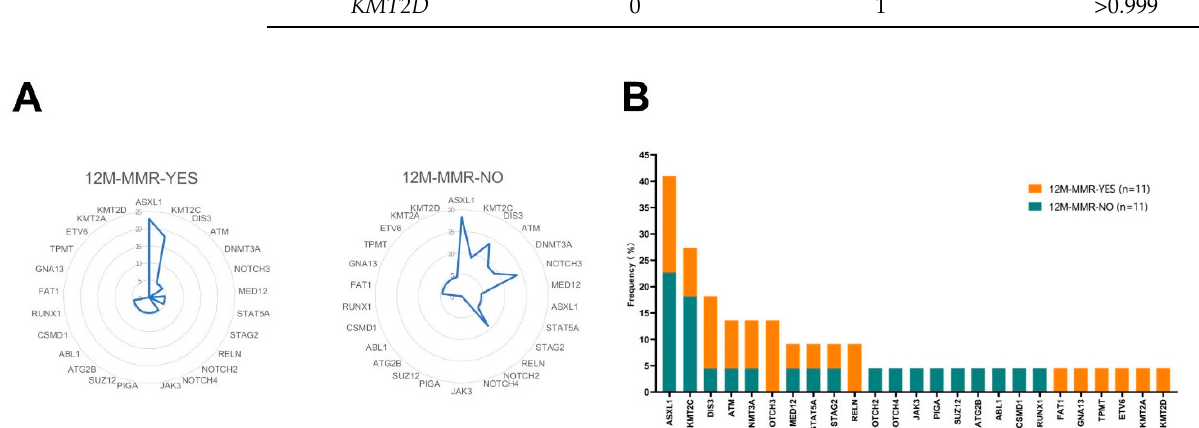
Figure 2. Mutation spectrum and frequency in the 12M-MMR group and non-12M-MMR group. ( A ) Mutation spectrum in the 12M-MMR group and non-12M-MMR group; ( B ) Mutation frequency in the 12M-MMR group and non-12M-MMR group.